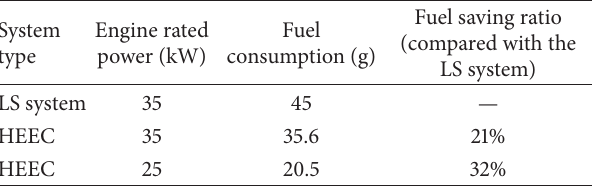
Table 1: Fuel consumption values of different system